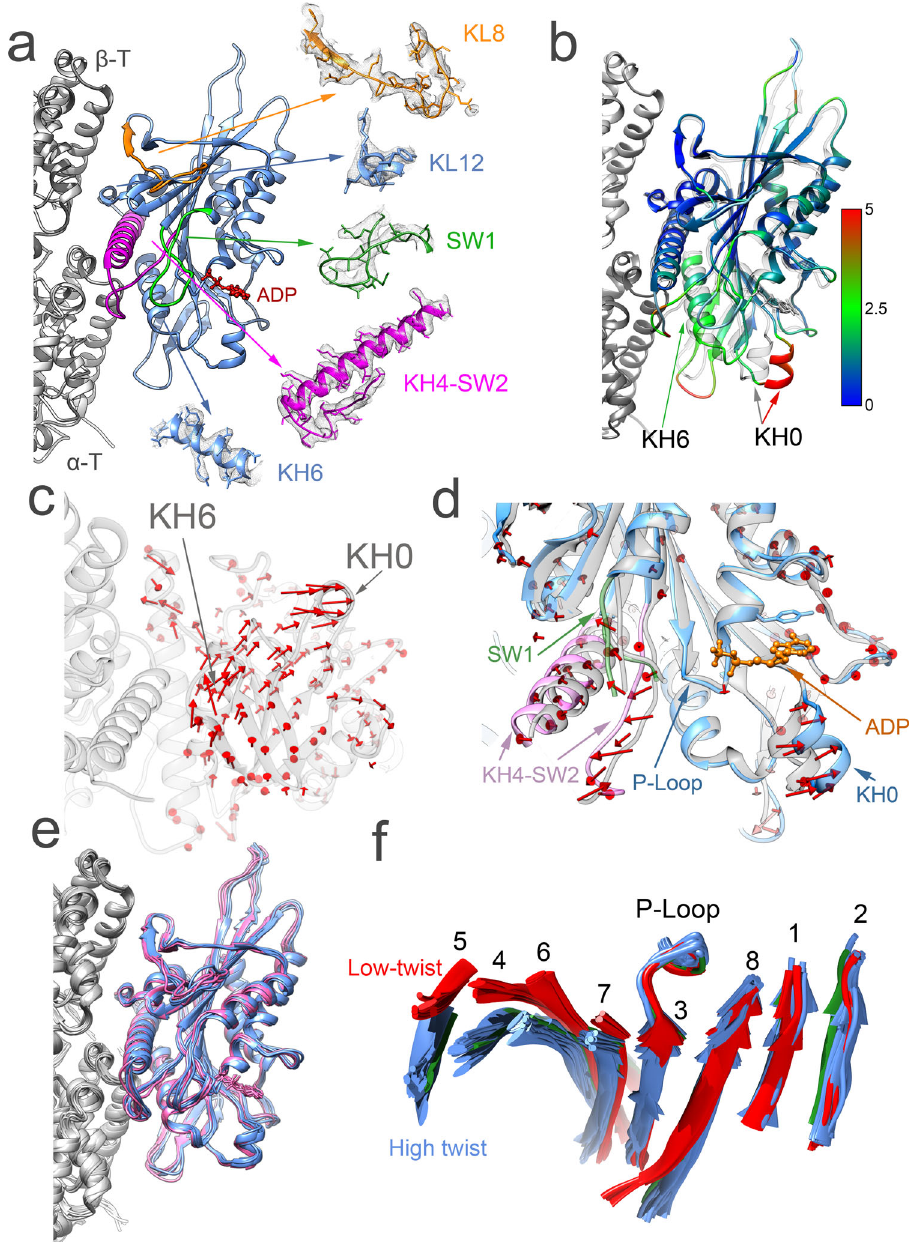
Fig. 3 Microtubule-bound ADP and Apo structures. a Side view of MT-K748-ADP atomic model structure. Insets show regions at the KIF14-microtubule interface (KL8, KL12, KH4, and KH6) and the switch loops (SW1 and SW2) with corresponding experimental density (gray mesh). b MT-K748-ADP (colored) and KIF14-ADP motor domain crystal structure (PDB: 4OZQ, semi-transparent gray) comparison. Structures are aligned to the KIF14 regions that interact with β -tubulin in the MT-K748-ADP structure (KL8 and KL12). The KIF14 motor domain of the MT-K748-ADP structure is colored by the distance to equivalent C α atoms in the microtubule-unbound structure (semitransparent gray) according to the inset scale (in Å). c Displacement vectors (red arrows) between equivalent KIF14 motor domain C α atoms in the MT-K748-ADP (light gray) and KIF14-ADP crystal structure. Structure alignment as in ( b ). d Nucleotide-binding pocket comparison between microtubule-unbound KIF14 (KIF14-ADP crystal structure, semitransparent gray) and microtubule- bound KIF14 (MT-K748-ADP, colored) structures. Both structures are aligned to their corresponding P-loops. e Superimposed MT-KIF14 complex structures (alignment as in b ) in the ADP (pink) and Apo states (blue). f Superimposed central β -sheet of all the MT-KIF14 complex structures (aligned to their corresponding P-loops). Numbers corresponds to the kinesin motor domain β -strands KS1 to KS8. Based on the amount of twist of the central β - strand, the structures separate into two major groups: a more twisted group (blue and green) and a less twisted group (red). The low-twist structures (red) correspond to complexes in the closed conformation group and the high-twist structures to the semi-closed (green) and open/open* (blue) conformation groups. The orientation of the displayed structures relative to the microtubule is with the plus end up for ( a ), ( b ), and ( d ) and with the plus end away from the viewer in c and f . KH0, KH4, KH6: kinesin α -helix-0, 4, and 6. KL8, KL12 kinesin loop 8 and 12; SW1, SW2 kinesin switch-1 and switch-2 loops; α -T, β -T α - and β